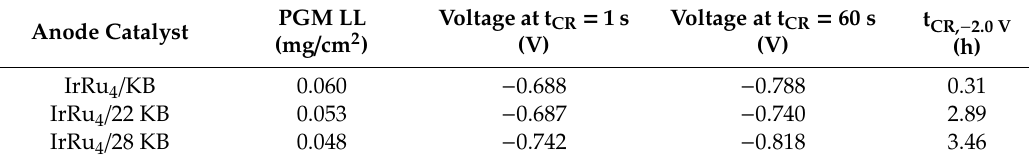
Table 3. Results of cell reversal tests using IrRu 4 dispersed on di ff erent types of carbon supports. Anode